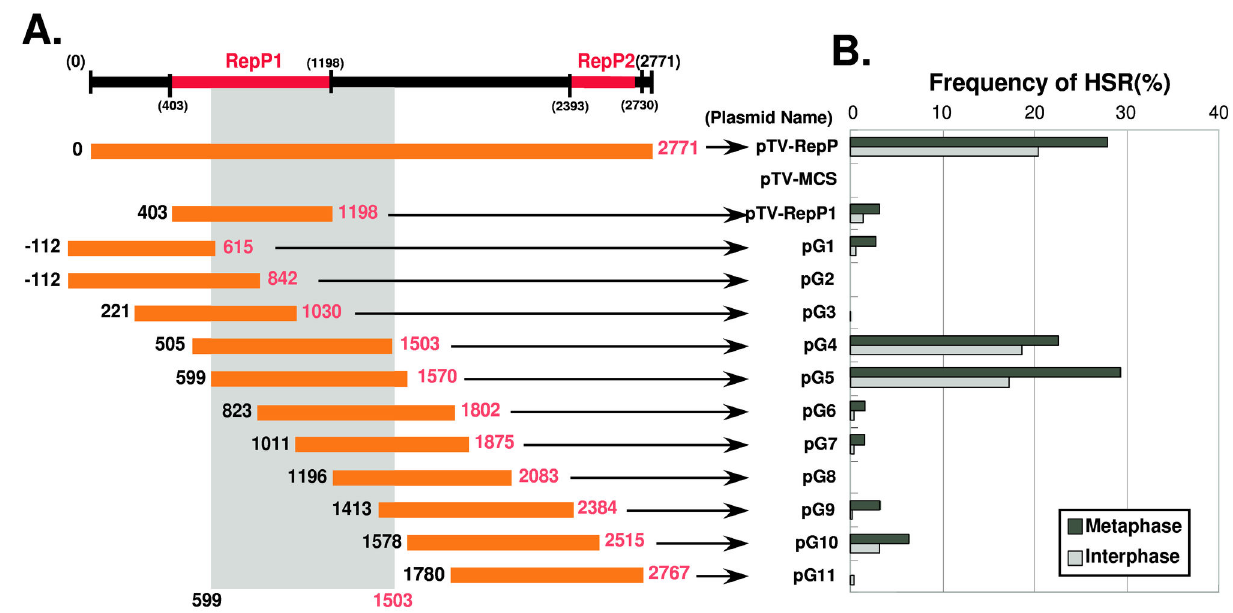
Figure 4. Dissection of ß-globin replicator using a plasmid-stability assay (2). The regions indicated by the orange bars in the left panel were subjected to the plasmid-stability assay in COLO 320DM cells, as in Figure 2. The results are shown in the right panel. The data suggest that the gray rectangular region drawn in the left panel has HSR-generation activity.